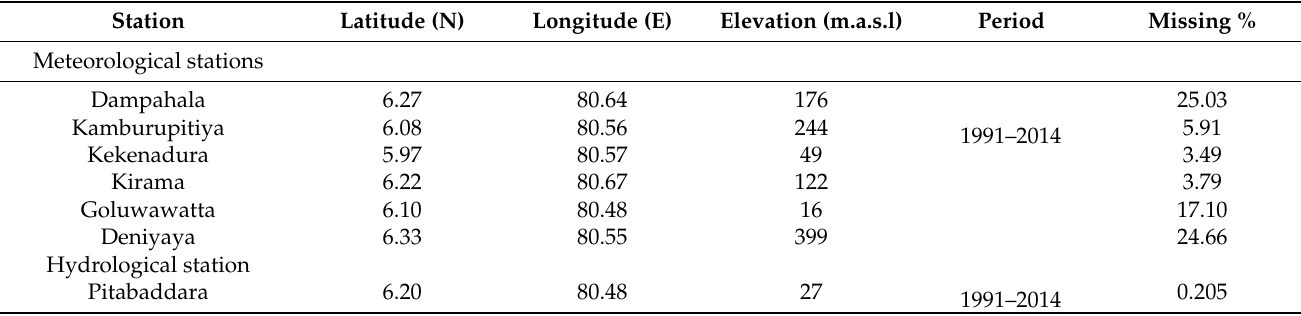
Table 1. General information of the stations used.